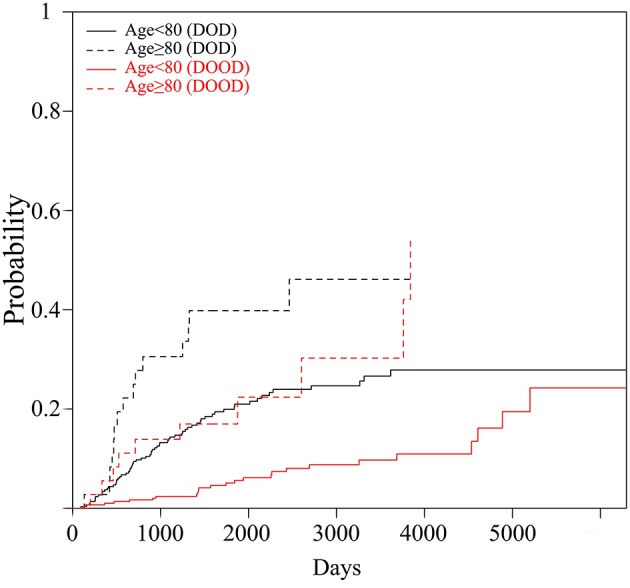
The graph shows cumulative incidence estimation of the probability of the occurrence of DOOD and DOD by the two age groups (Age <80 vs. Age≥80).